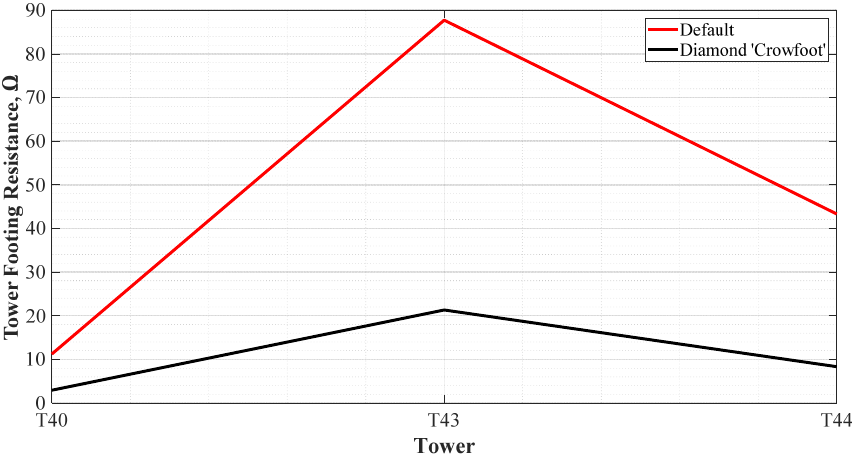
Figure 13. Computed TFR values for towers T40, T43 and T44 based on two earthing designs.